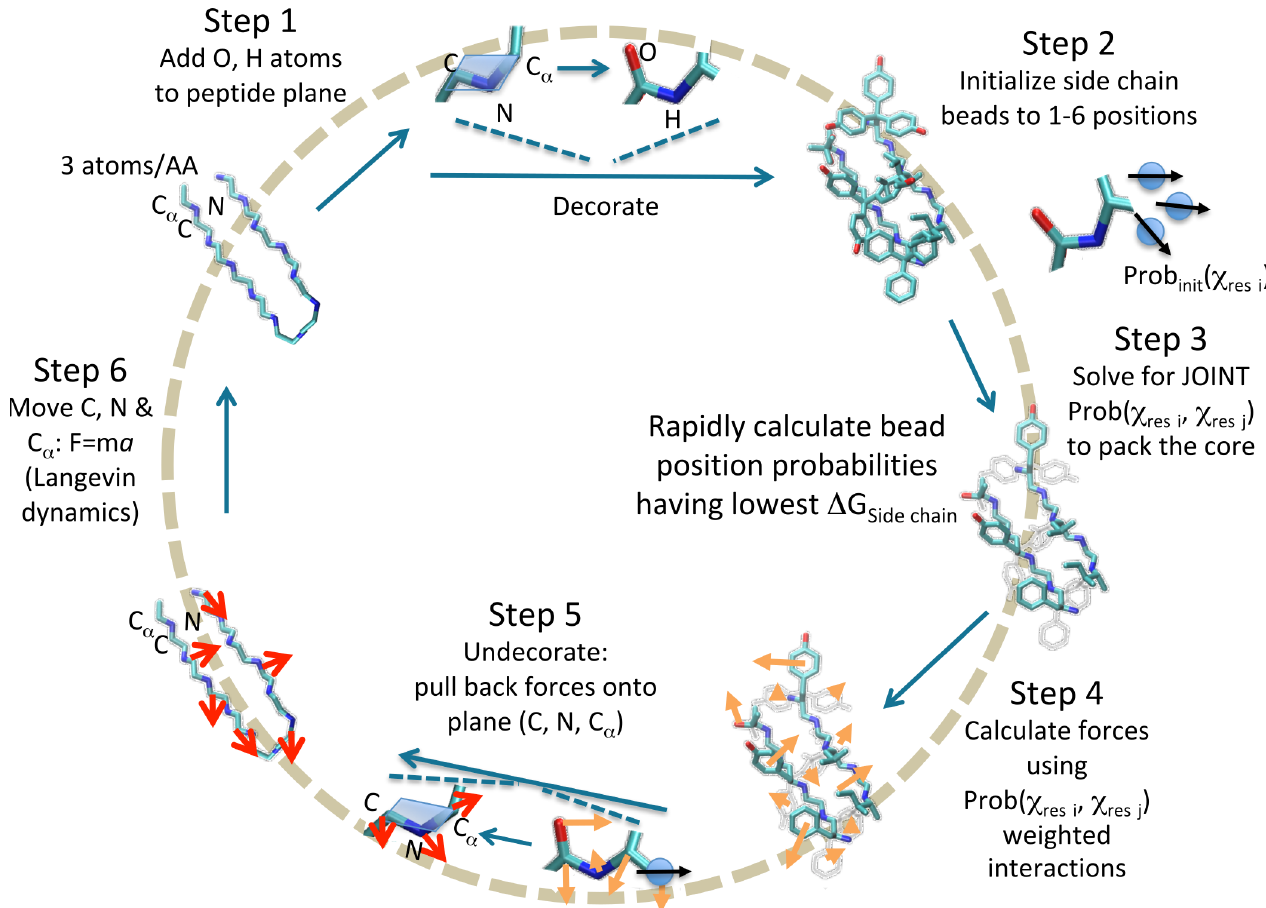
Fig 1. Six step inner loop of Upside calculation. The side chain potential enters into the integration step simply as a complicated, many-body energy function that may be treated with standard techniques of molecular simulations.